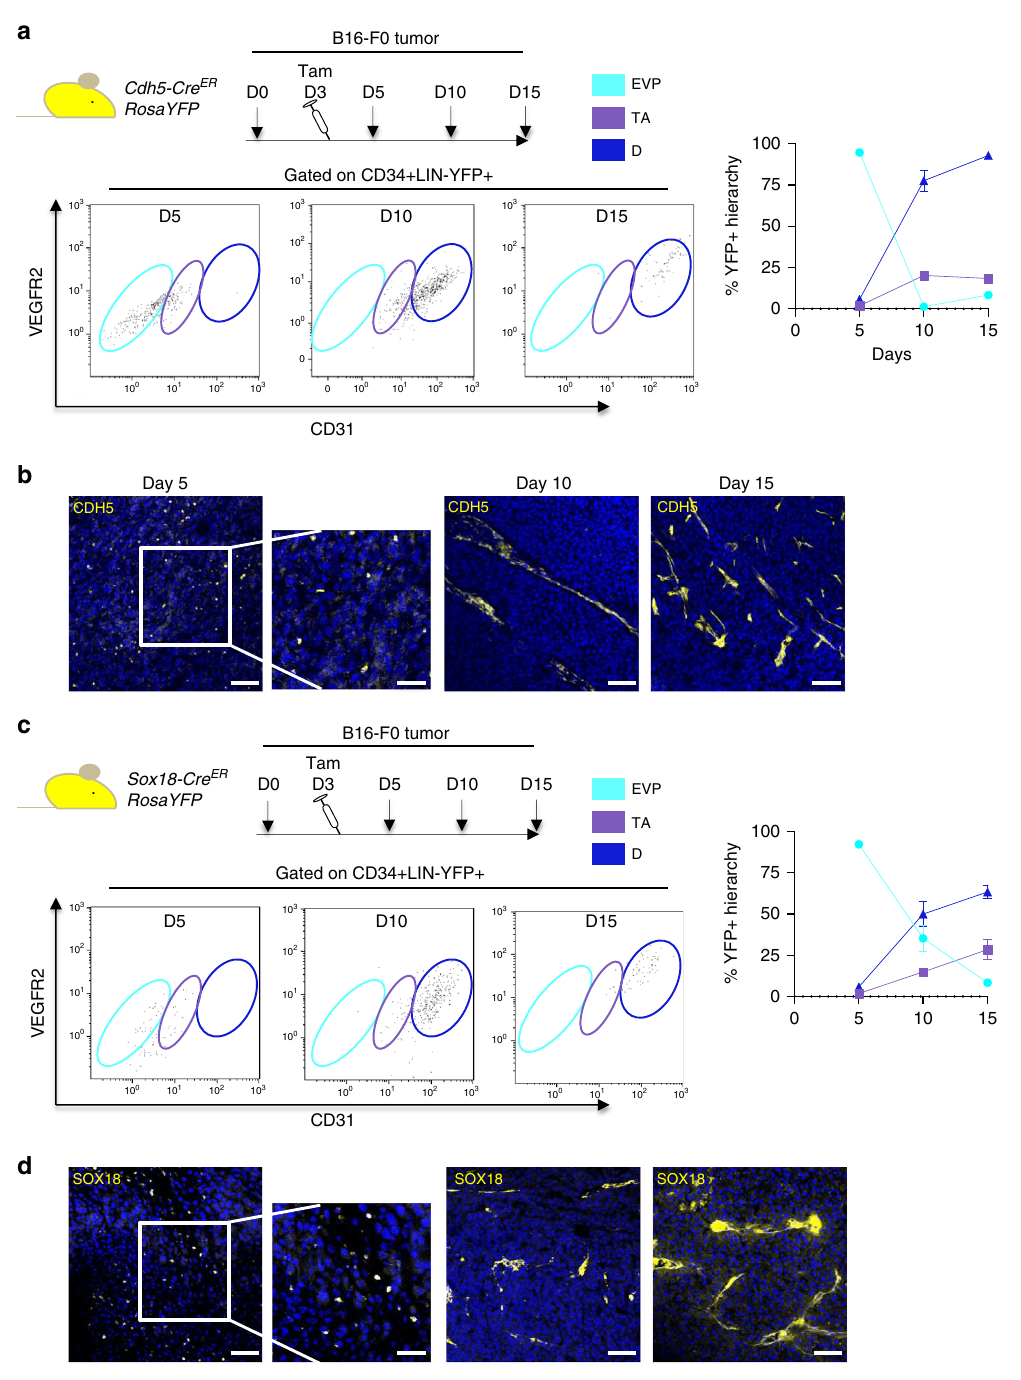
Fig. 2 Lineage tracing reveals the kinetics of the endothelial hierarchy in tumors. a Schematic diagram of the Cdh5-Cre ER RosaYFP lineage tracing model employed with B16-F0 melanoma cells injected at day 0 (D0), with mice receiving tamoxifen (Tam) 3-days post tumor inoculation. Flow cytometry plots demonstrate that D5 post tumor inoculation, only EVP and TA amongst CD34 + LIN-YFP + cells can be observed. At D10 EVP are absent and by D15 only mature D cells can be observed ( n = 5). b Immuno fl uorescence at D5 shows individual YFP + foci. At D10 and 15 entire YFP + vessel structures can be observed. c Schematic diagram of the Sox18-Cre ER RosaYFP lineage tracing model employed with B16-F0 melanoma cells injected at day 0 (D0), with mice receiving tamoxifen (Tam) 3-days post tumor inoculation. Flow cytometry plots demonstrate that D5 post tumor inoculation, only EVP and TA amongst CD34 + LIN-YFP + cells can be observed. At D10 EVP are absent and by D15 only mature D cells can be observed ( n = 5). d Immuno fl uorescence at D5 shows individual YFP + foci. At D10 and 15 entire YFP + vessel structures can be observed. Scale bar represents 50 and 150 μ m, respectively. Results presented as mean ± SEM. EVP endovascular progenitor, TA transit amplifying, D de fi nitive